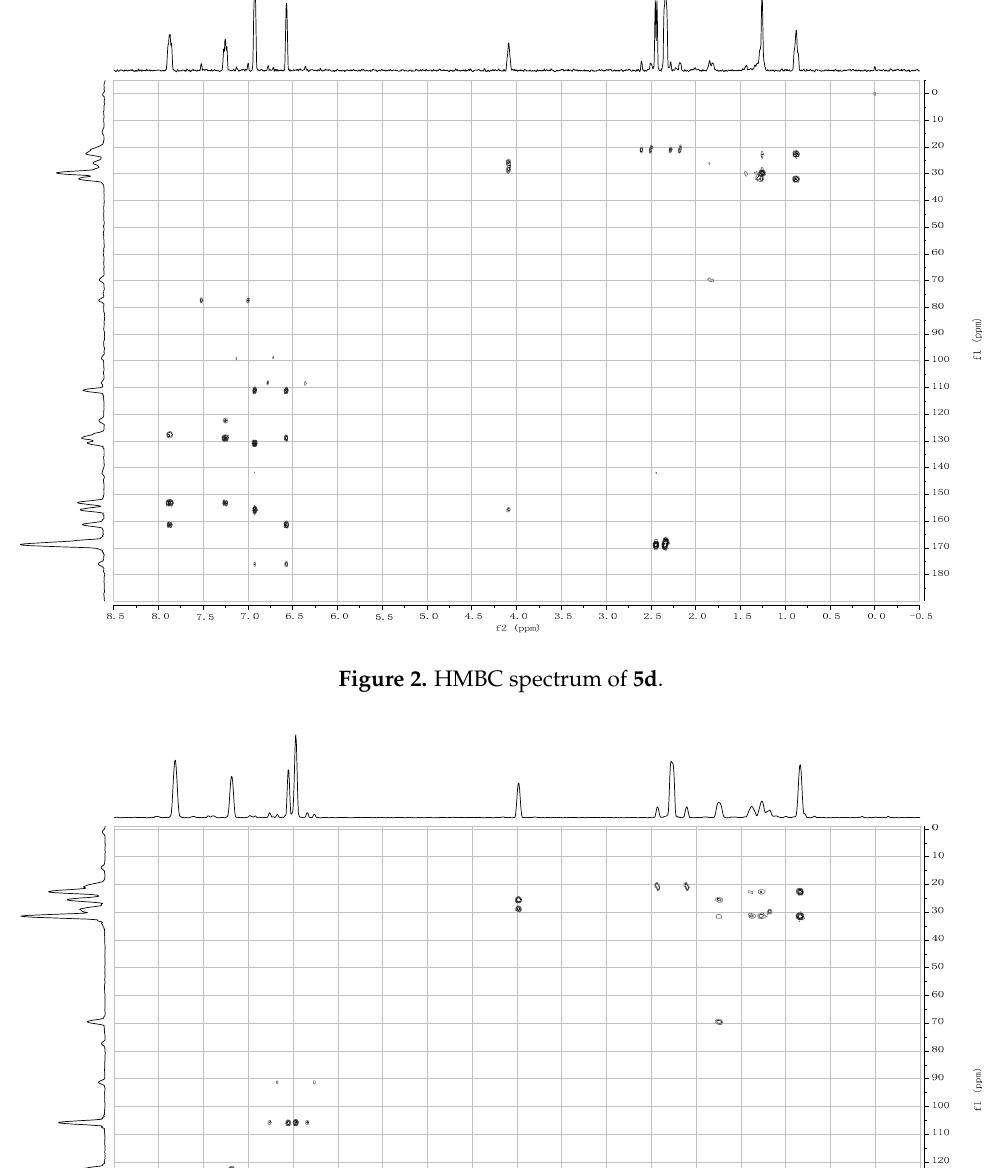
Figure 3. HMBC spectrum of 6a .